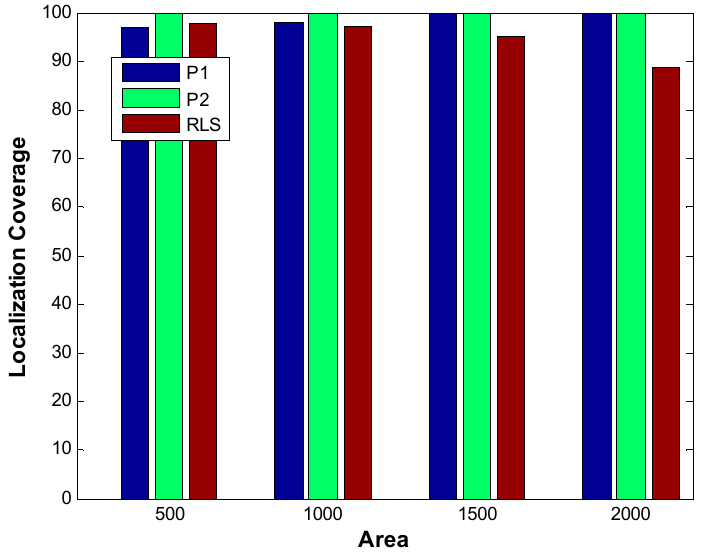
Figure 18. Localization coverage (sparsity).